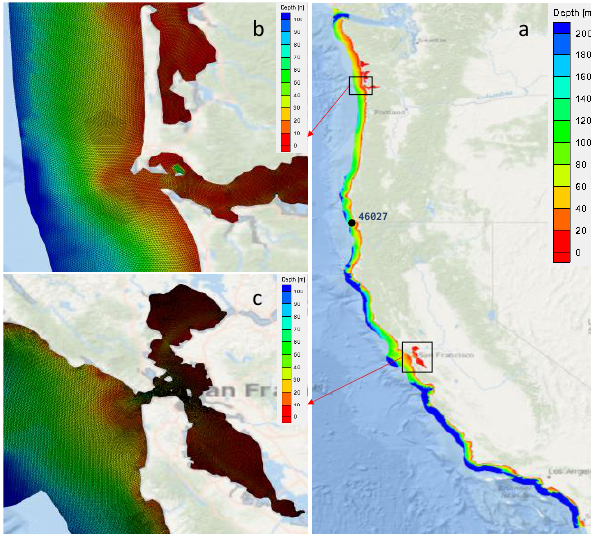
Fig. 2. UnSAWN model domain for U.S. West Coast (a), zoomed-in model grids near the mouth of Columbia River (b) and San Francisco Bay (c).